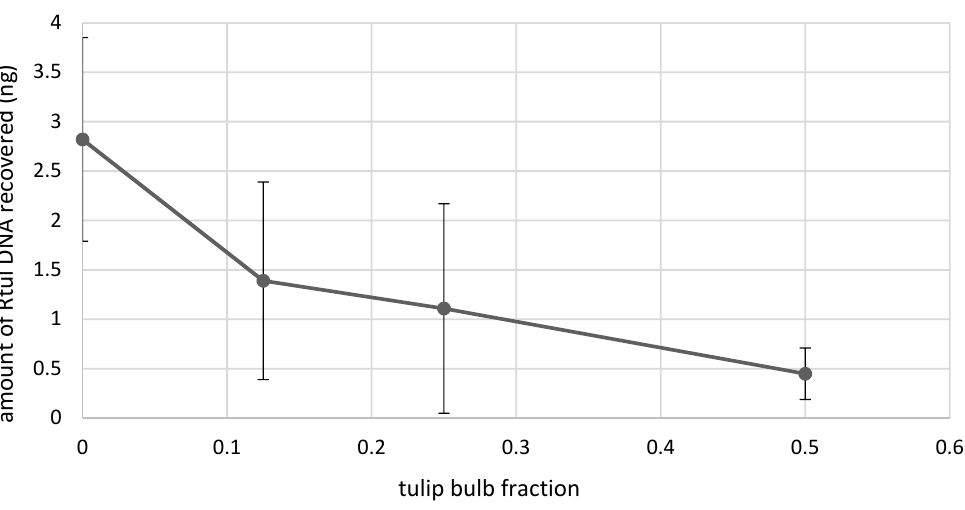
Figure 5. Analysis of the effect of tulip bulb tissue on sensitivity of qPCR detection of Rhizoctonia tuliparum DNA. 14.25 mg sclerotia (equivalent of 8 average size lab-grown sclerotia) were added to various fractions of tulip bulb tissue to determine the limit of detection of sclerotial DNA in infected bulbs by Rtul qPCR. The amount of R. tuliparum DNA detected was compared to the amount of R. tuliparum DNA in sclerotia in the absence of bulb tissue. The presence of bulb tissue reduced the ability to detect R. tuliparum .